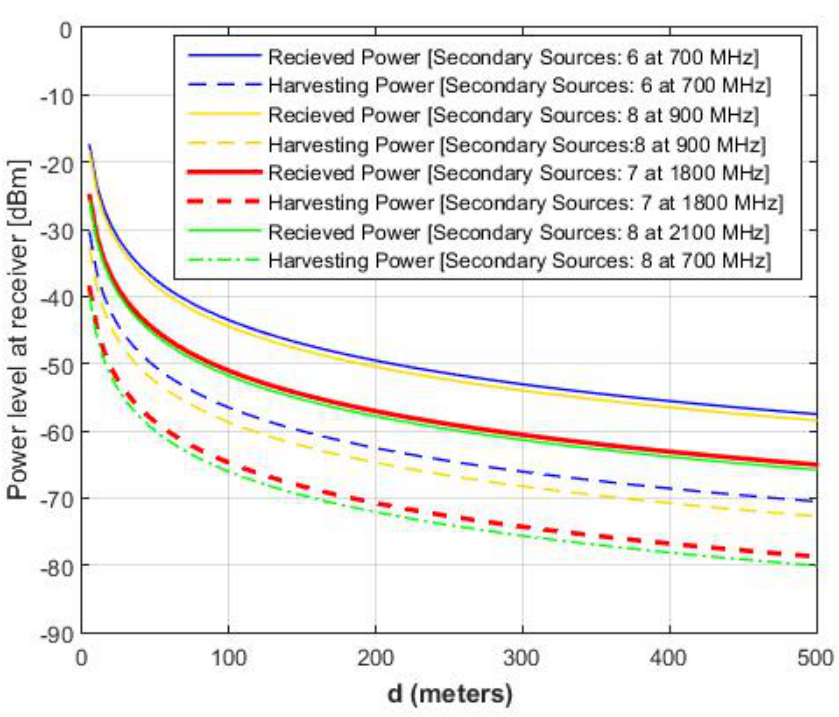
Figure 5. Probability of successful reporting for different node-classification